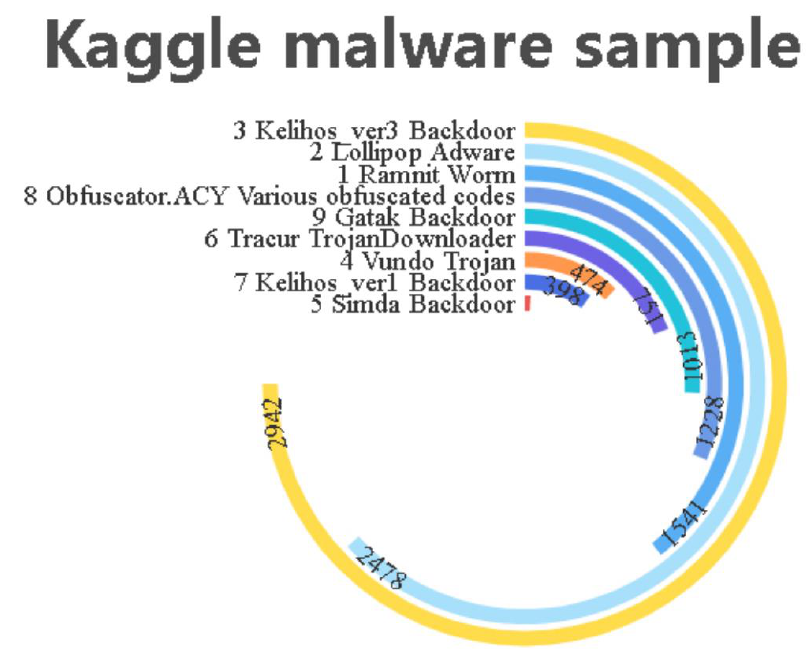
Figure 10. Kaggle malware sample.